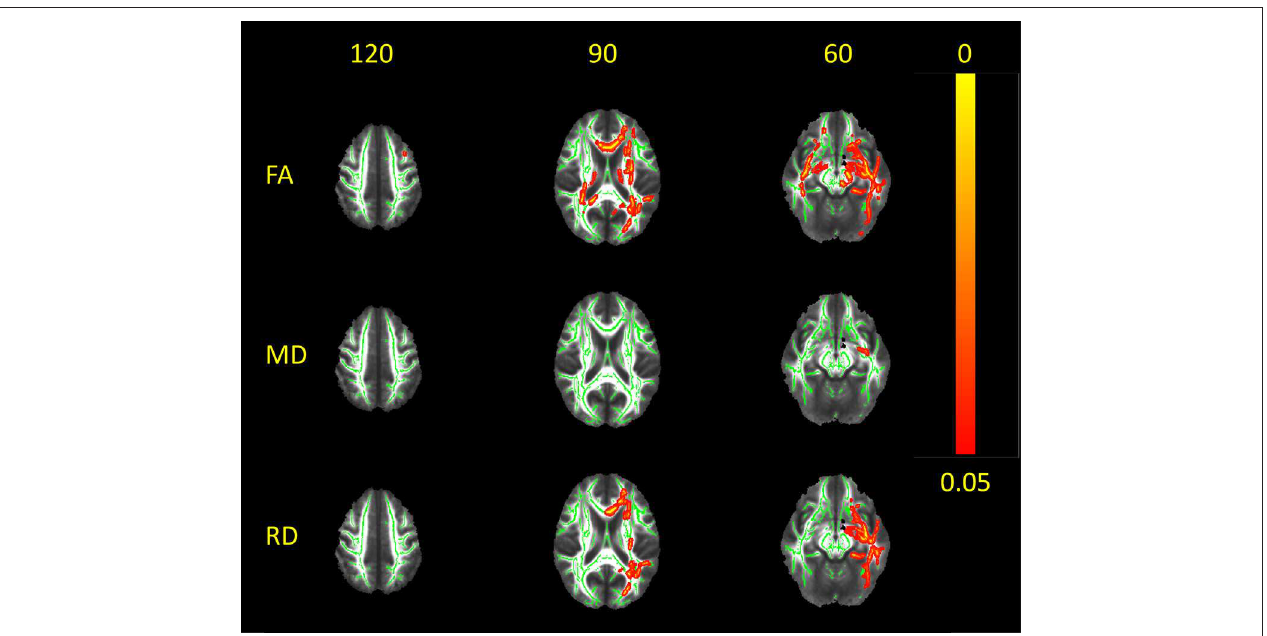
FIGURE 3 | White matter alterations in LTLE as compared to normal controls. Red-yellow clusters indicate statistically significant results in patients: clusters of reduced FA and increased RD in the center of main fiber bundles (along with focal clusters of increased MD) are more restricted to the ipsilateral hemisphere. Significant clusters were thickened in order to obtain better visualization. Results are overlaid on the mean FA image; the WM skeleton thresholded at 0.2 is shown in green. Images are thresholded at p < 0.05, corrected for multiple